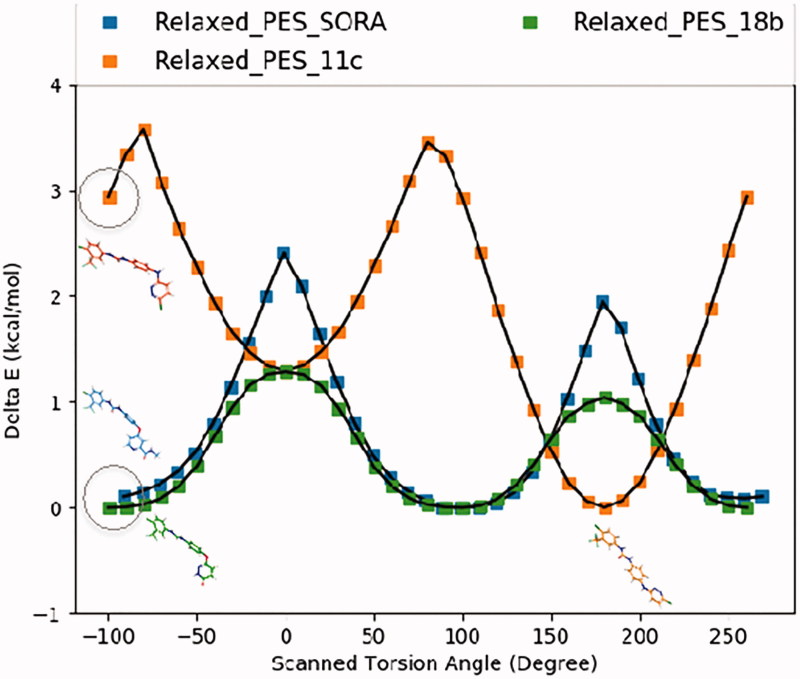
The relaxed PES scan of the torsional angel of the selected linker. The scan was initiated from a sorafenib bound-like conformation for all ligands such that they start and end approximately at the same value of the torsional angle. Representative conformations for the most stable (global energy minimum) conformation are given in the figure. For SORA and 18b, this conformation corresponds to the bioactive conformation, whereas for 11c, this conformation (planar) is not the bioactive one, i e, not the conformation required to form an H-bond with the hinge residues. The carbon atoms of each ligand are coloured similarly to the scanning steps. The scan was performed at the B3LYP/6–31 + G* level of theory.